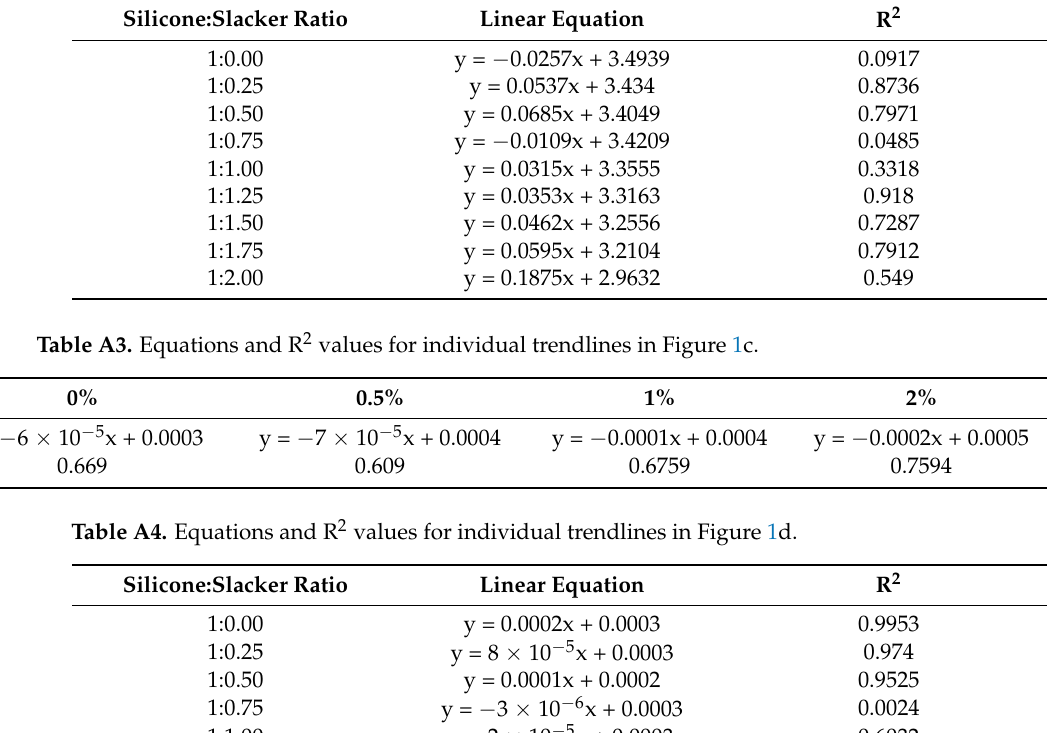
Table A5. Significant difference in conductivity between various Thi-vex concentrated groups. A significant difference was indicated with O and an insignificant difference was indicated with x.